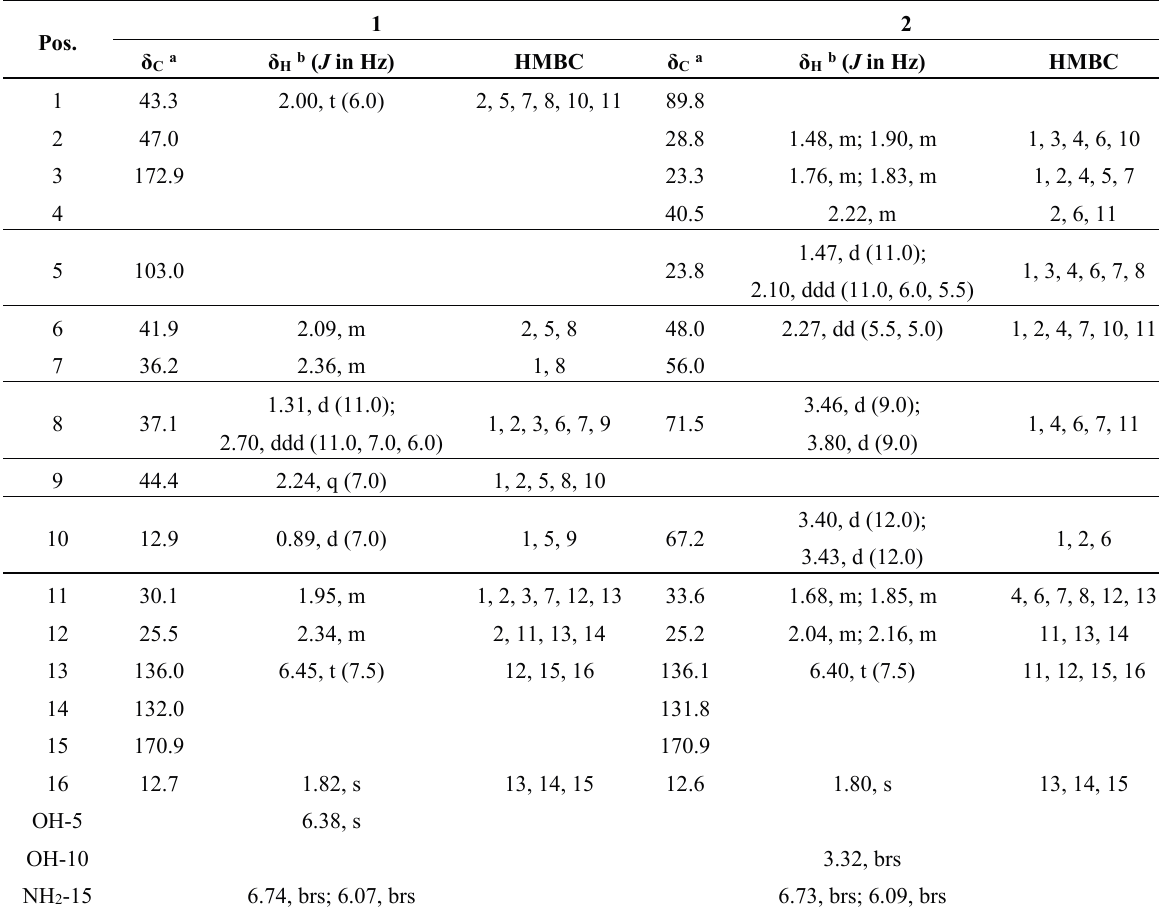
Table 1. NMR Data for 1 and 2 (Acetone- d 6 ).